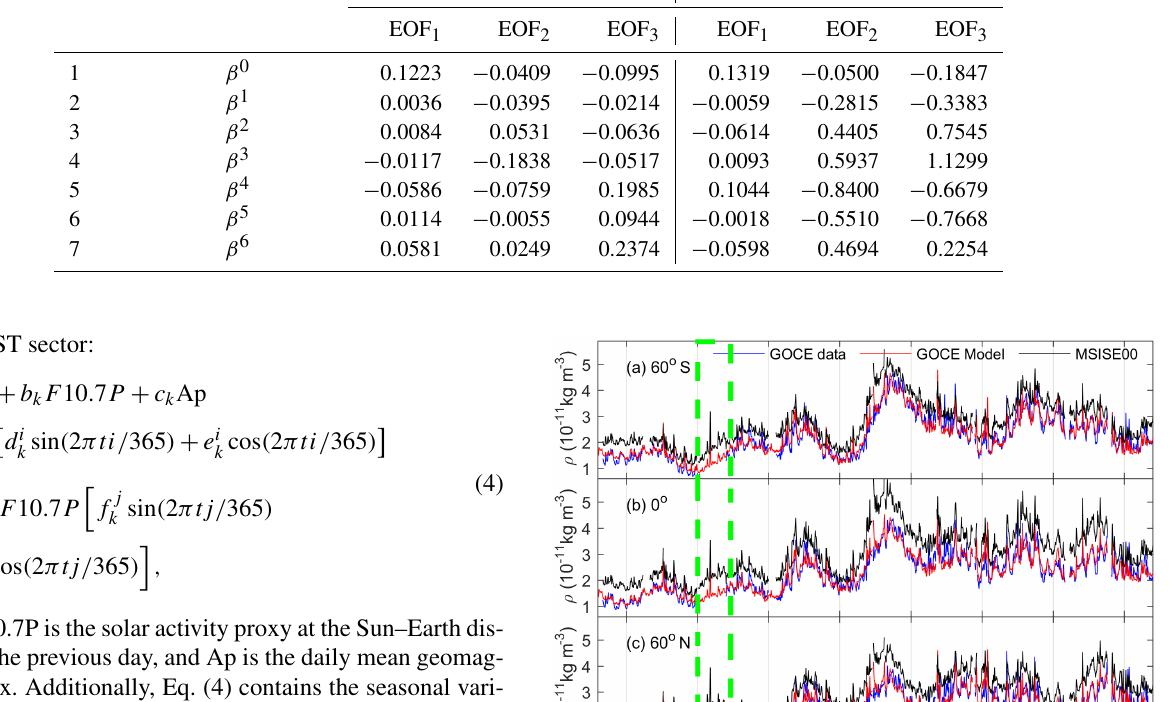
Table 1. The coefficients of the first three EOFs fitted from Eq. (3) at the dawn and dusk LST sectors. Serial number Coefficients Dawn